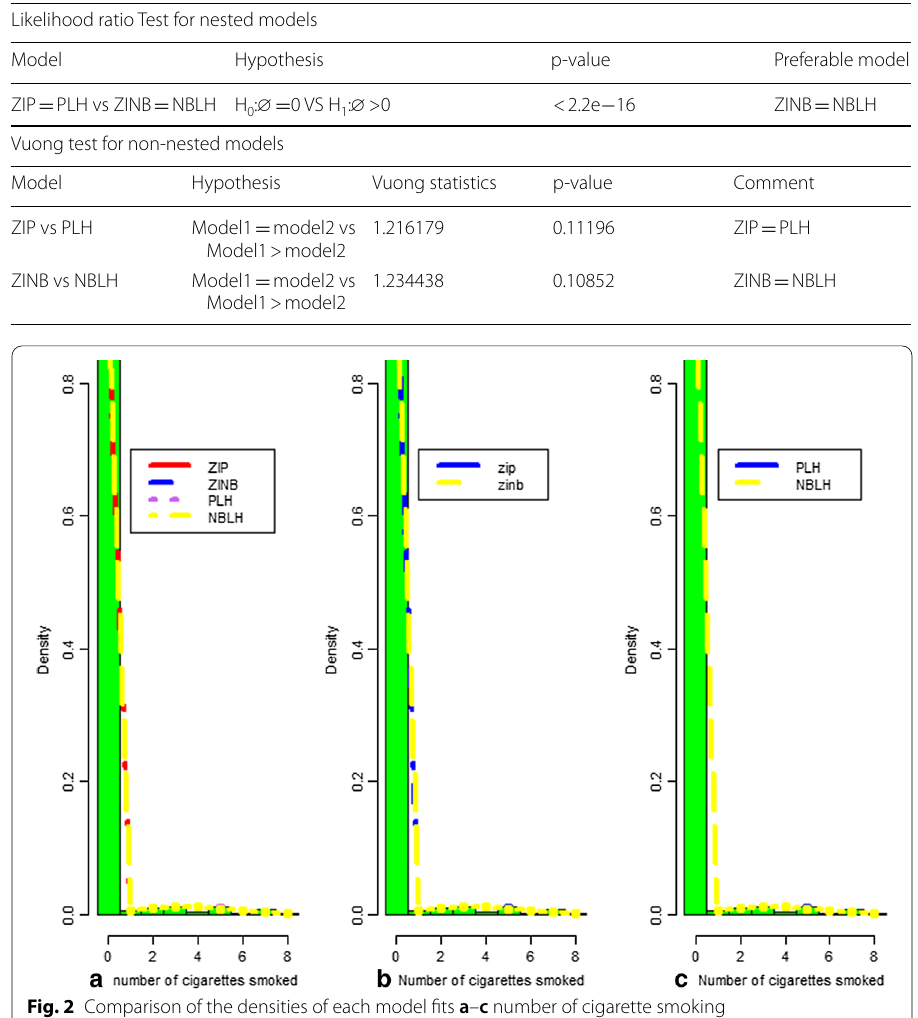
Table 1 The likelihood ratio test (LRT) and Vuong test among the ZIP, ZINB, PLH, and NBLH models Likelihood ratio Test for nested models